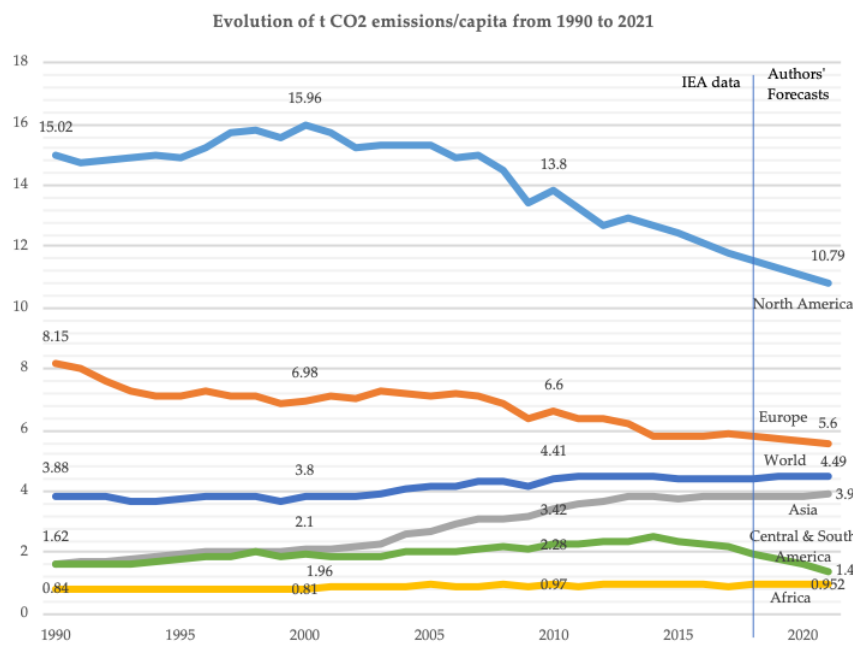
/ capita from 1990 to 2017 (Source: Figure 15. Evolution of CO 2 emissions/capita from 1990 to 2017 (Source: IEA). Figure 15. Evolution of CO 2 emissions Figure 15. Evolution of CO 2 emissions/capita from 1990 to 2017 (Source: IEA).